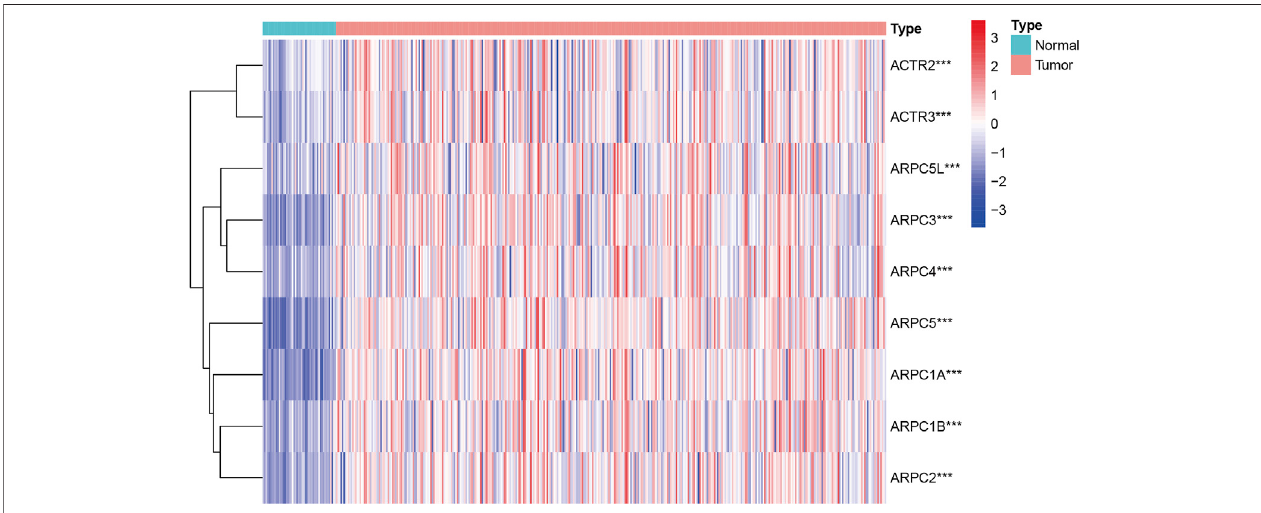
FIGURE 2 | Expression pro fi le level of Arp2/3 complex members in HCC tissues visualized using a heatmap. Red stands for overexpression, and blue represents down-expression. ***stands for p < 0.001.